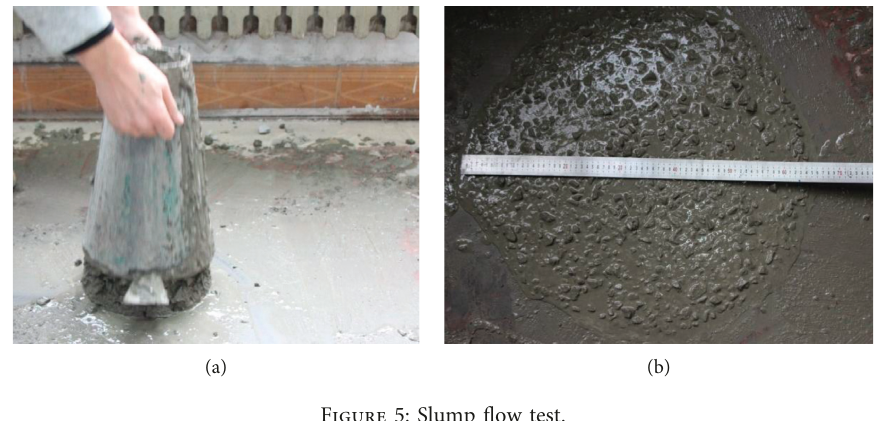
Figure 5: Slump flow test.